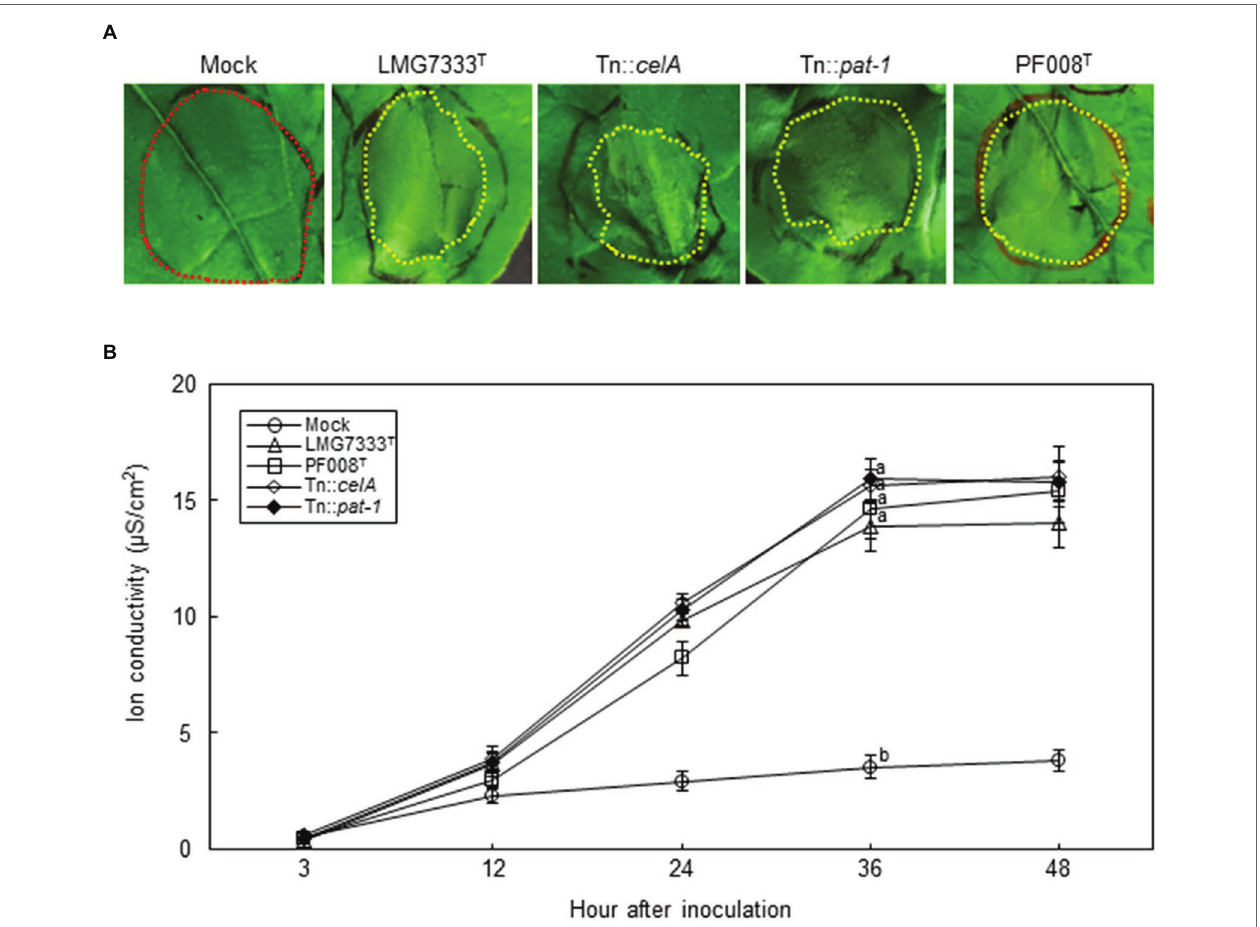
FIGURE 4 | Influence of two major virulence genes of C . michiganensis for necrosis on N . benthamiana leaves. (A) The necrosis symptoms on N . benthamiana leaves by infiltration with 10 8 CFU/ml of C . capsici PF008 T , C . michiganensis LMG7333 T and its mutant strains. Each red and yellow dotted line indicates no symptom and necrotic parts, respectively. Photos showing necrosis symptoms were taken at 48 hours after infiltration (hai), respectively. (B) The measurement of ion conductivity on N . benthamiana leaves after inoculation with 10 8 CFU/ml of the bacterial strains. The letters at the time points in the graphs indicate a statistically significant difference analyzed via Duncan’s multiple range test ( p < 0.05). Similar results were obtained from two independent assays. Mock, 10 mM MgCl 2